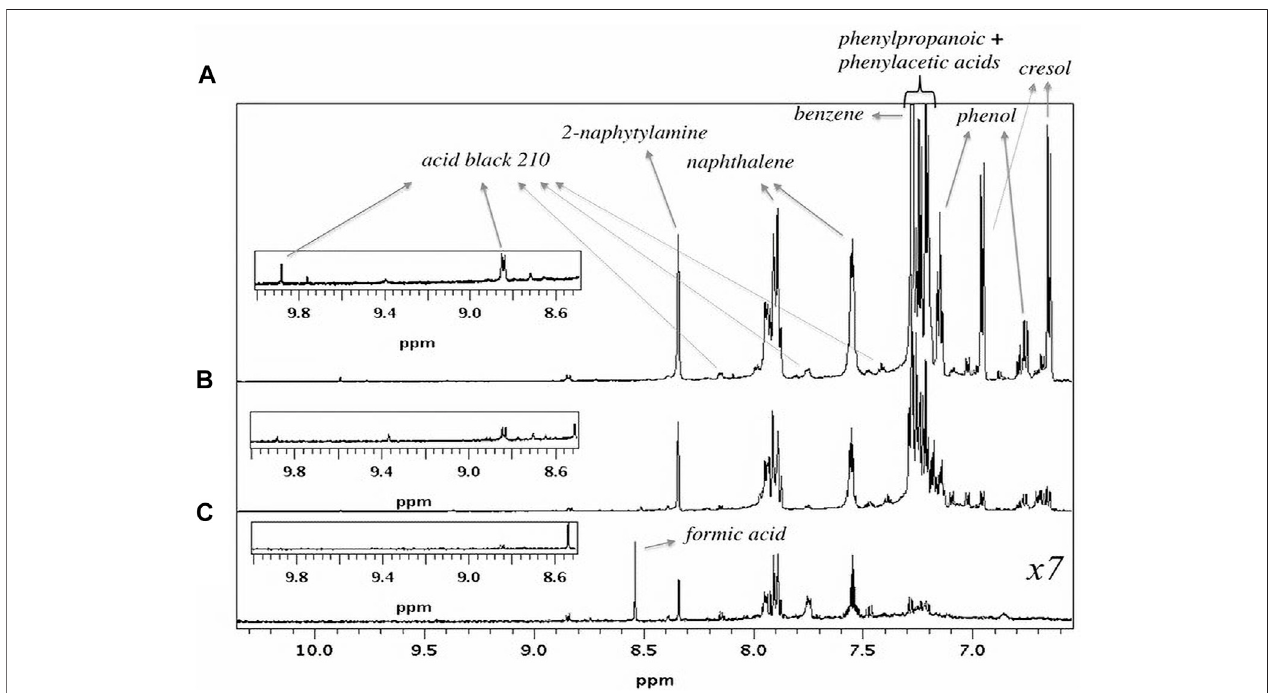
FIGURE7| 1 HNMRanalysisobtainedforthesamplecollectedfrom (A) untreatedand (B) treatedef fl uentbythebiologicalsystemand (C) sampleofriverreceiving discard from the tannery industry.